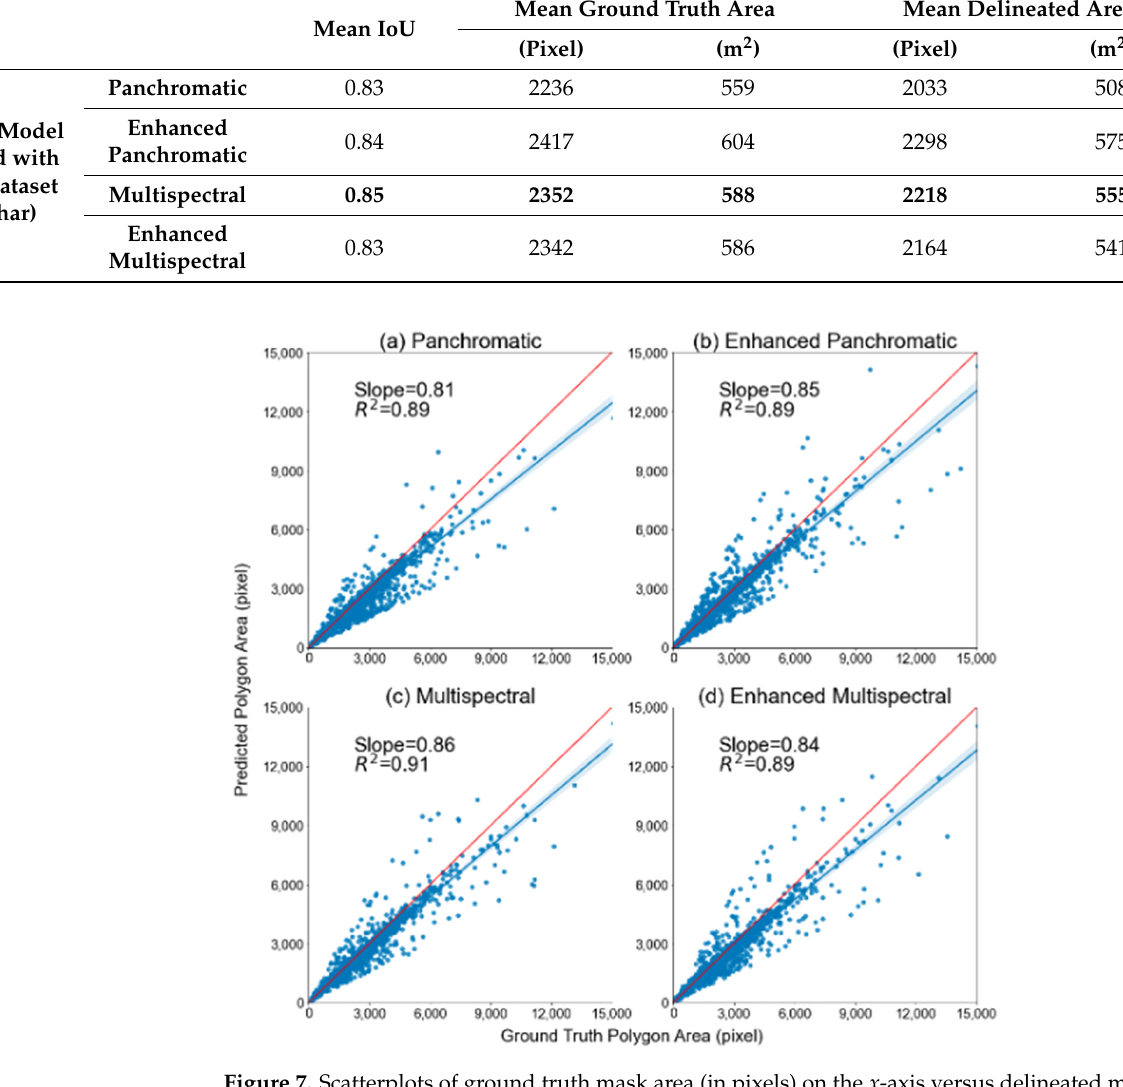
Figure 7. Scatterplots of ground truth mask area (in pixels) on the x -axis versus delineated mask area (in pixels) on the y -axis. Only correctly delineated field masks are included. Plots ( a – d ) represent results for each image type for the models applied in Uttar Pradesh. Blue lines with shading represent the linear regression line with 95% confidence intervals, and red lines represent the one-to-one line.